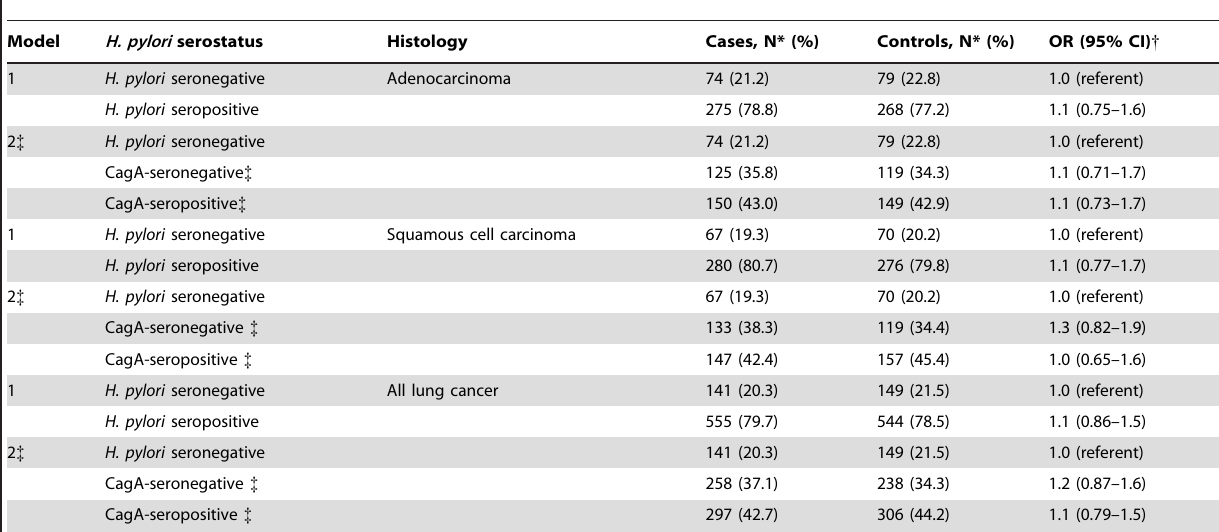
Table 2. Association of Helicobacter pylori ( H. pylori ) seropositivity with risk of lung adenocarcinoma and squamous cell carcinoma in the Alpha-Tocopherol, Beta-Carotene Cancer Prevention